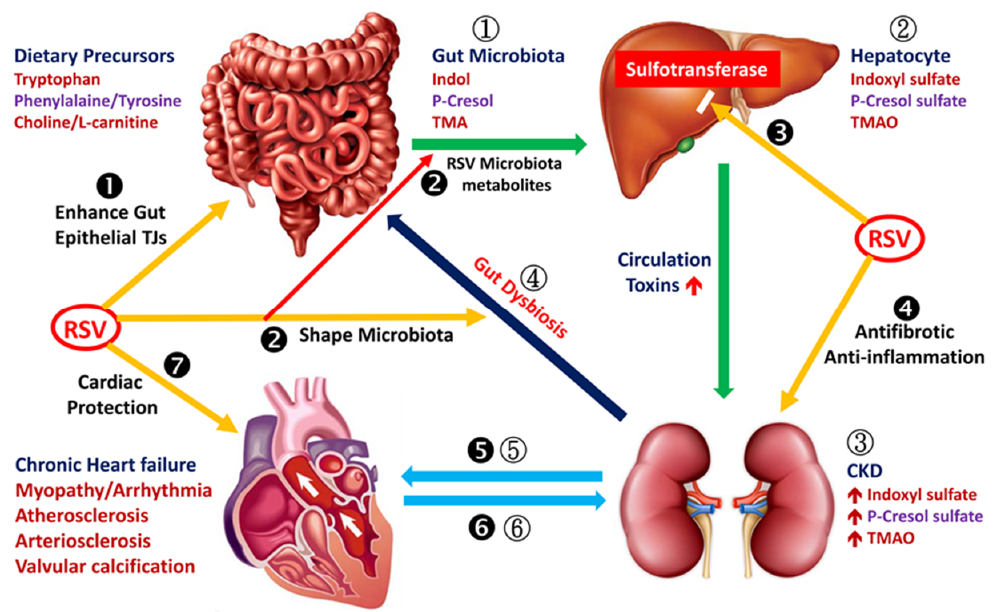
Figure 1. Resveratrol (RSV) suppresses uremic toxins and improves their effect on the cardiovascular system. Foods containing tryptophan, phenylalanine/tyrosine and